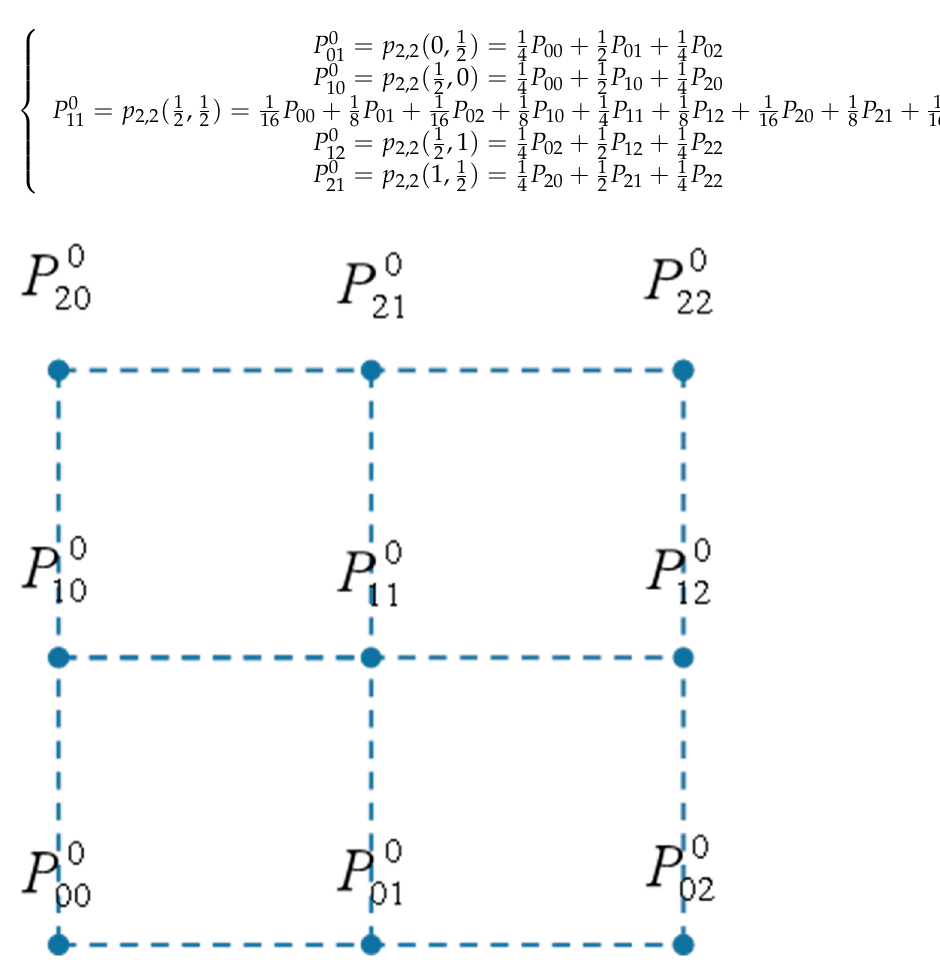
Figure 1. Distribution of the data points.